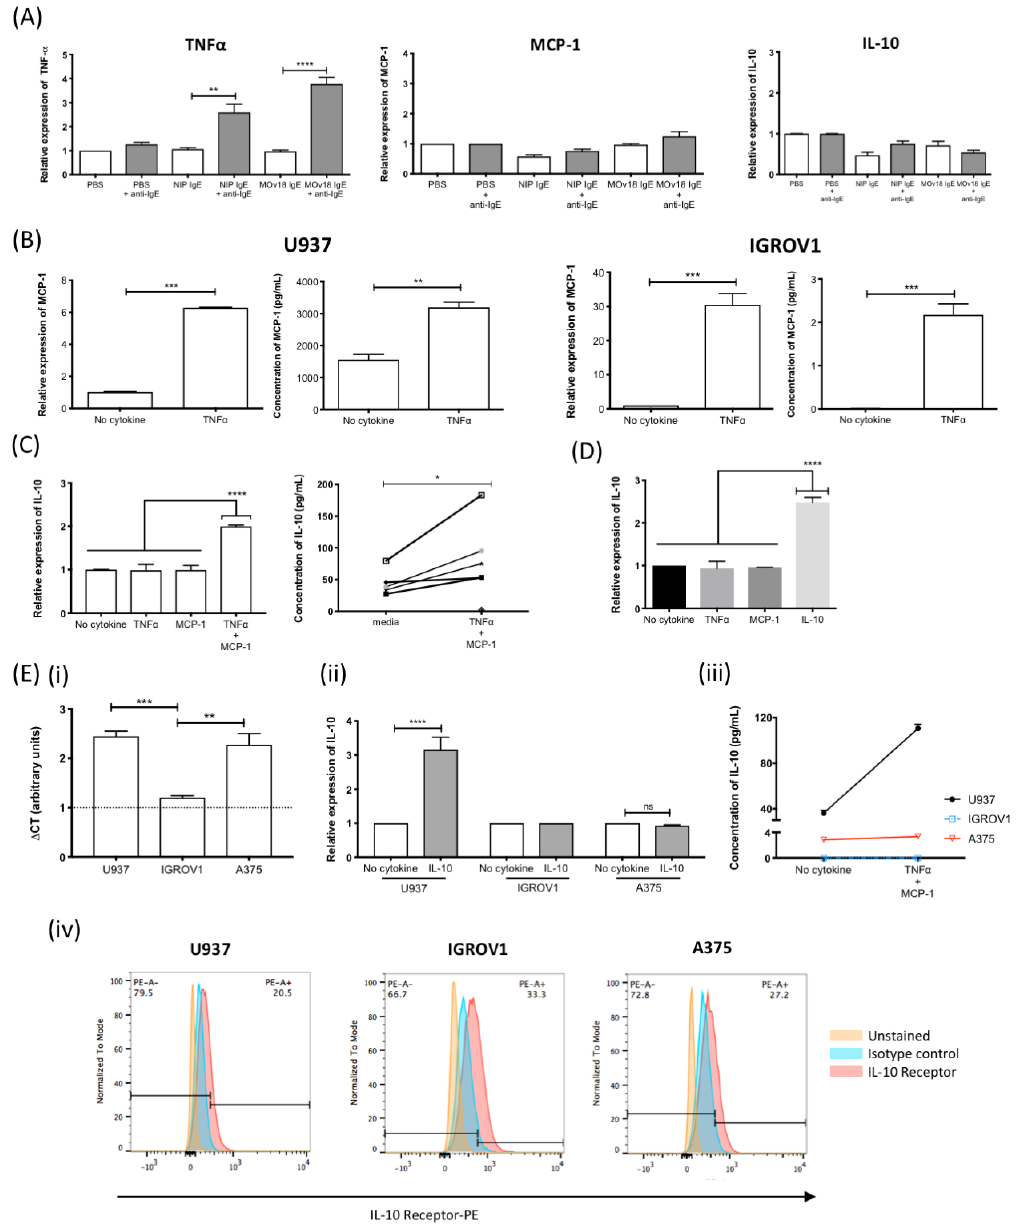
Figure 5. IgE cross-linking on monocytic cells induces a TNF α / MCP-1 / IL-10 cascade. ( A ) TNF α , MCP-1 and IL-10 mRNA expression by human monocytic U937 cells treated with bu ff er alone (PBS) or IgE antibodies (NIP IgE or MOv18 IgE) (white), or IgE cross-linked with polyclonal antibody (grey) ( n = 4). ( B ) MCP-1 mRNA and protein expression by U937 monocytes (left) and human ovarian IGROV1 (right) cells following TNF α stimulation ( n = 4). ( C ) IL-10 mRNA expression (left) and secretion (right) by U937 cells following TNF α + MCP-1 combined stimulation ( n = 5). ( D ) IL-10 mRNA expression by U937 cells following IL-10 stimulation ( n = 5). ( E ) Comparison of ( i ) baseline IL-10 expression (CT value units; n = 2), ( ii ) IL-10 mRNA expression following stimulation with and without IL-10 ( n = 2), ( iii ) IL-10 secretion following TNF α + MCP-1 combined stimulation ( n = 2), and ( iv ) IL-10 receptor expression of U937, IGROV1, and human melanoma A375 cell by flow cytometric analysis. Fold-change was calculated in relation to unstimulated cells. Error bars represent standard error of mean (SEM) of independent experiments. One-way ANOVA with Tukey’s post-test and Student’s t -test was performed to assess significance (* p < 0.05; ** p < 0.01; *** p < 0.001; **** p < 0.0001).